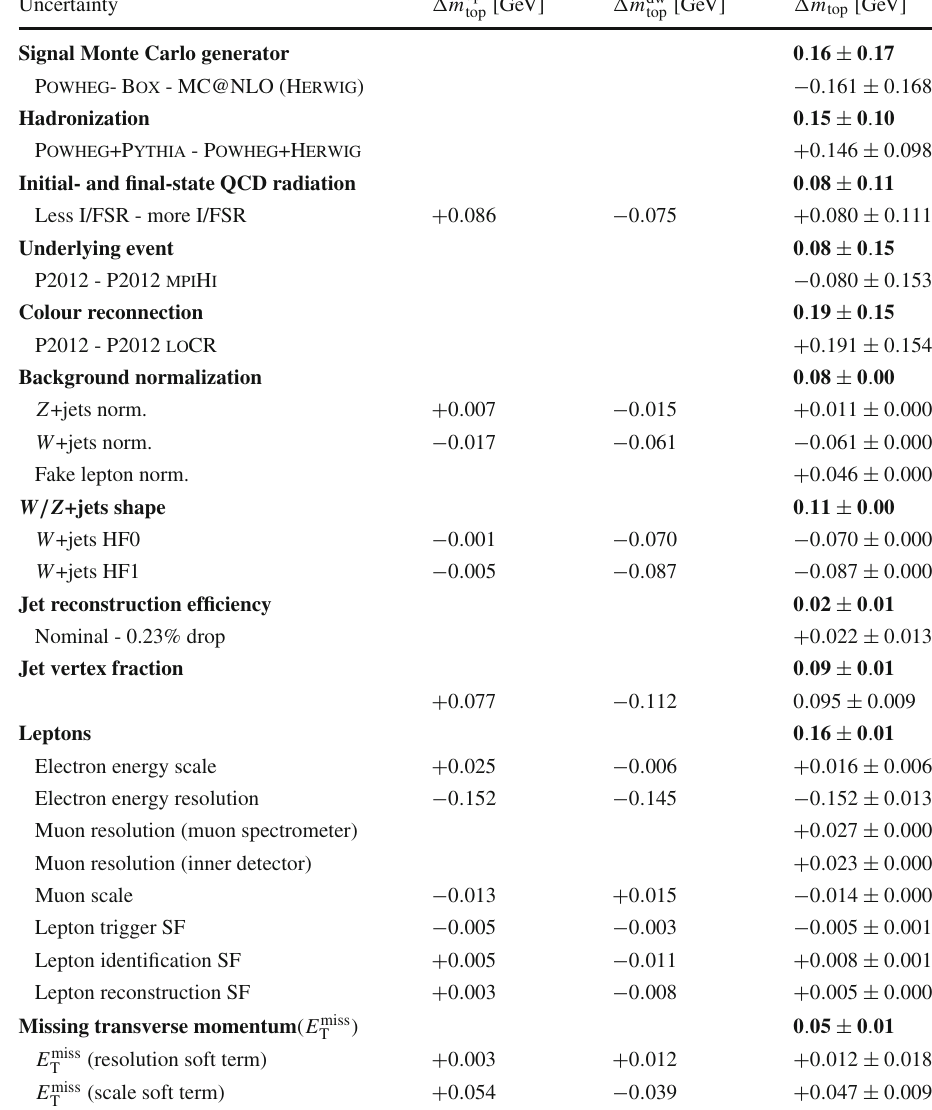
Table 8 The individual components of the uncertainty sources considered for the t ¯ t → lepton + jets analysis at √ s = 8 TeV for the sources of uncertainty not documented in Tables 9, 10, 11 and 12. The uncertainties together with their statistical precisions are listed in boldface and given with 0.01 GeV precision. The uncertainty per source is calculated as the sum in quadrature of the subcomponents.